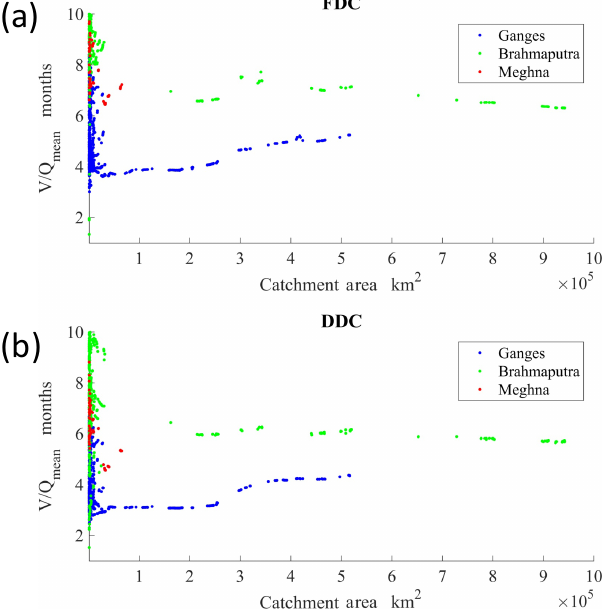
Figure 12. Relation between necessary storage (km 3 ) and catch- ment area (km 2 ) for (a) flood and (b) drought management in the three basins of the GBM basin.